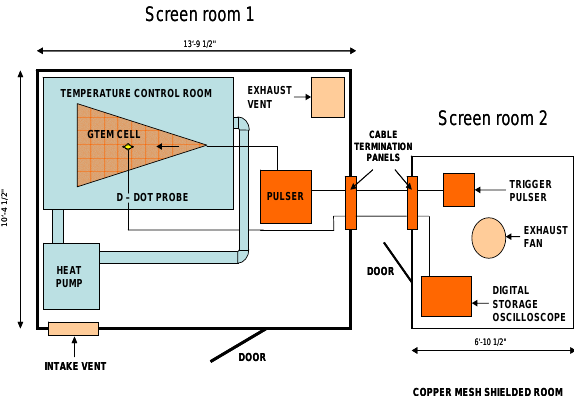
Figure 1: UWBR Exposure Facility at LA